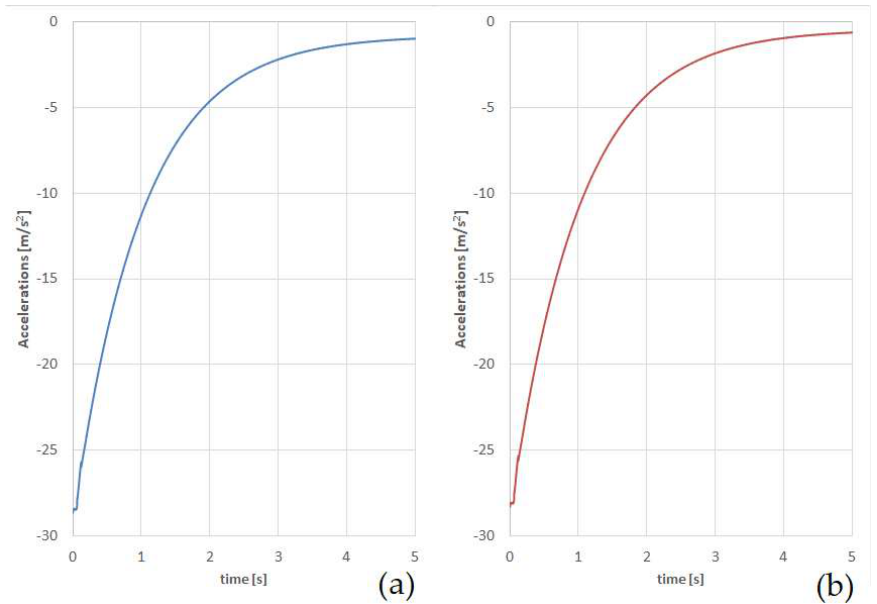
Figure 9. Accelerations on the carrying structure of the articulated hopper wagon: ( a ) first and ( b ) second sections of the flat wagon from longitudinal force.